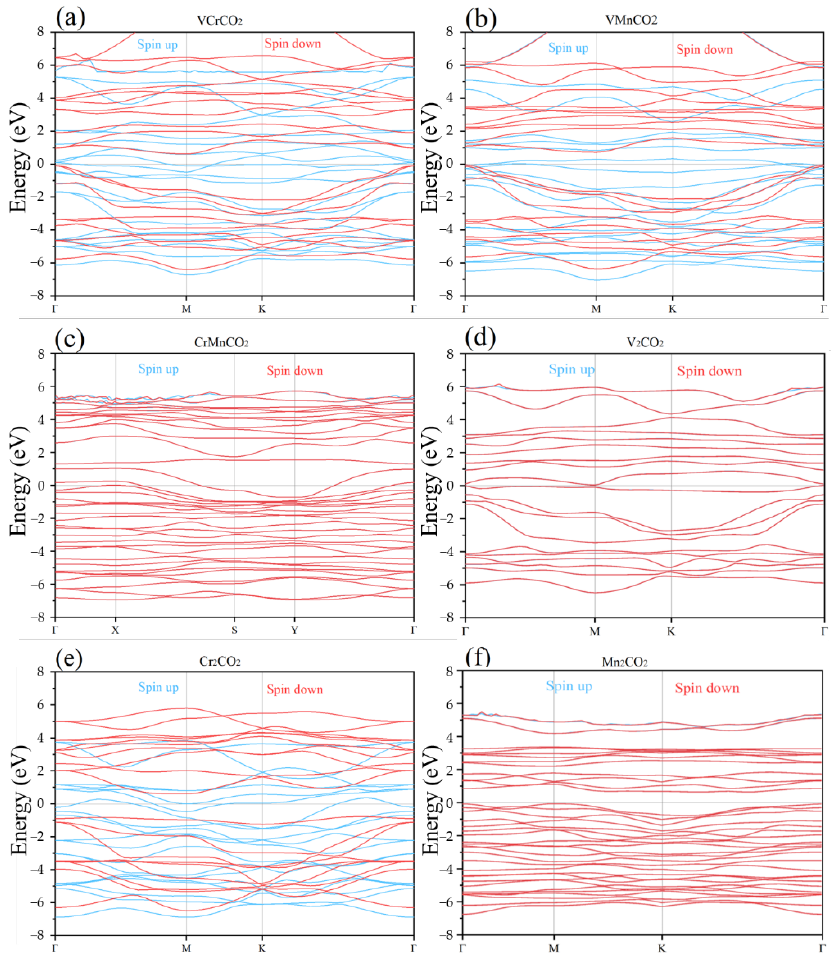
Figure 5. The band gap of M ’ MCO 2 . ( a ) VCrCO 2 ; ( b )VMnCO 2 ; ( c ) CrMnCO 2 ; ( d )V 2 CO 2 ; ( e ) Cr 2 CO 2 ; ( f ) Mn 2 CO 2 .